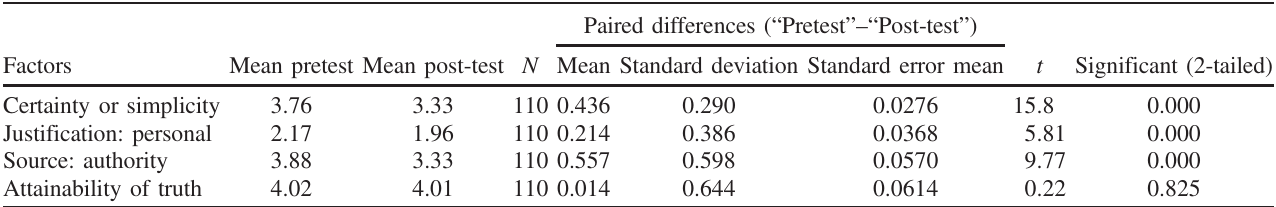
TABLE III. The results of paired t test for the control group in the Calgary study. Factors